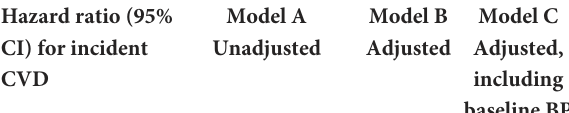
TABLE 3 Association of cumulative systolic blood pressure levels (continuous scale) with hazards of cardiovascular diseases – subgroups analysis (per 1 standard deviation).